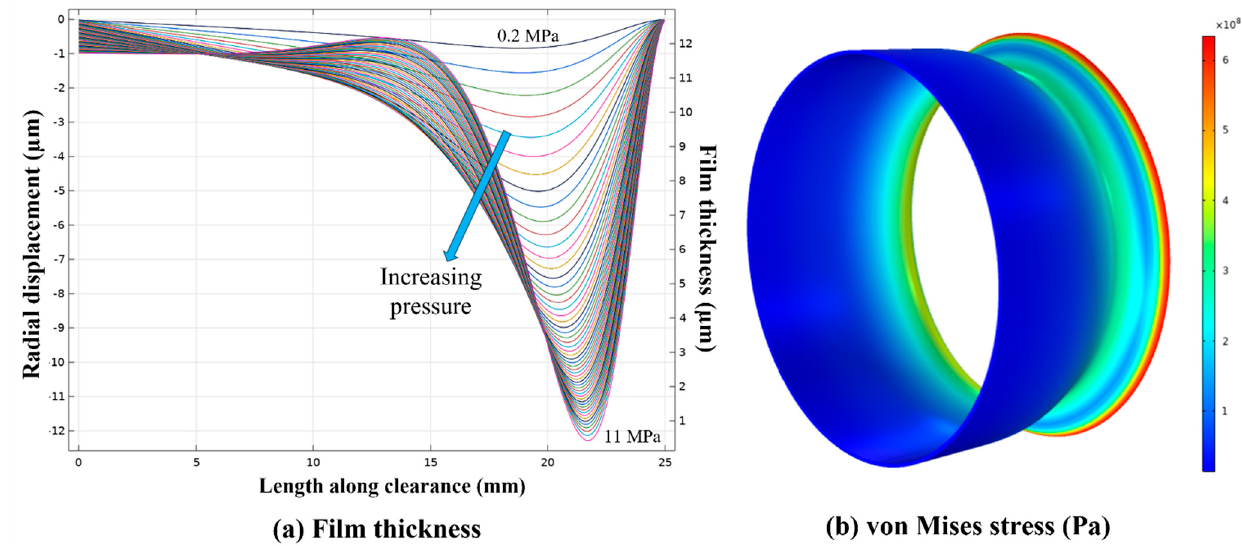
Figure 7. ( a ) Variation of radial displacement of the sleeve and the film thickness along the sleeve length at different inlet pressure conditions between 0.2 MPa and 11 MPa in increments of 1 MPa. ( b ) von Mises stress on the inner surface of the sleeve for P 0 = 5 MPa.